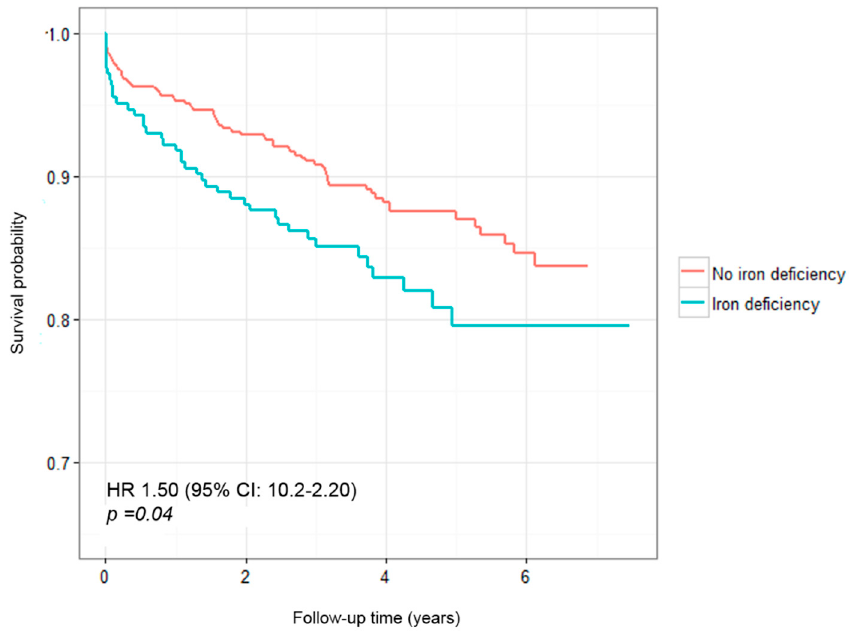
Figure 2. Survival curves for non-fatal myocardial infarction and cardiovascular mortality according to iron status.